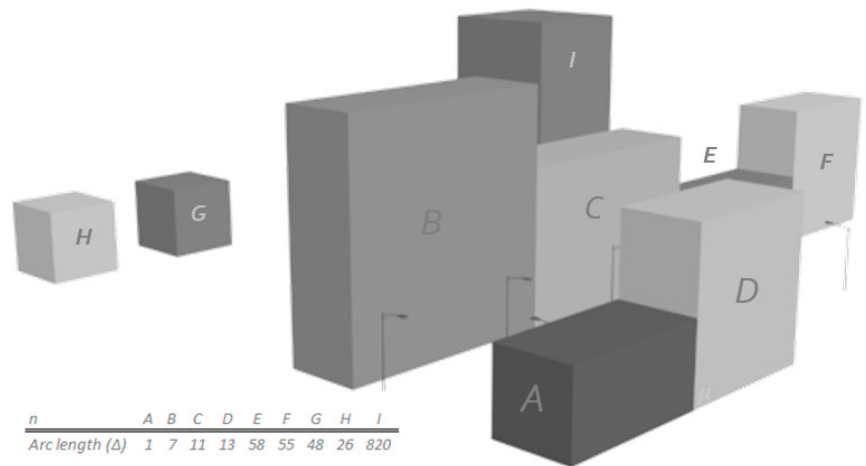
Figure 13. The nearest arc lengths from building A are B, C, and D, in that Figure 13: The nearest arc lengths from building A are B, C, and D, in that order.